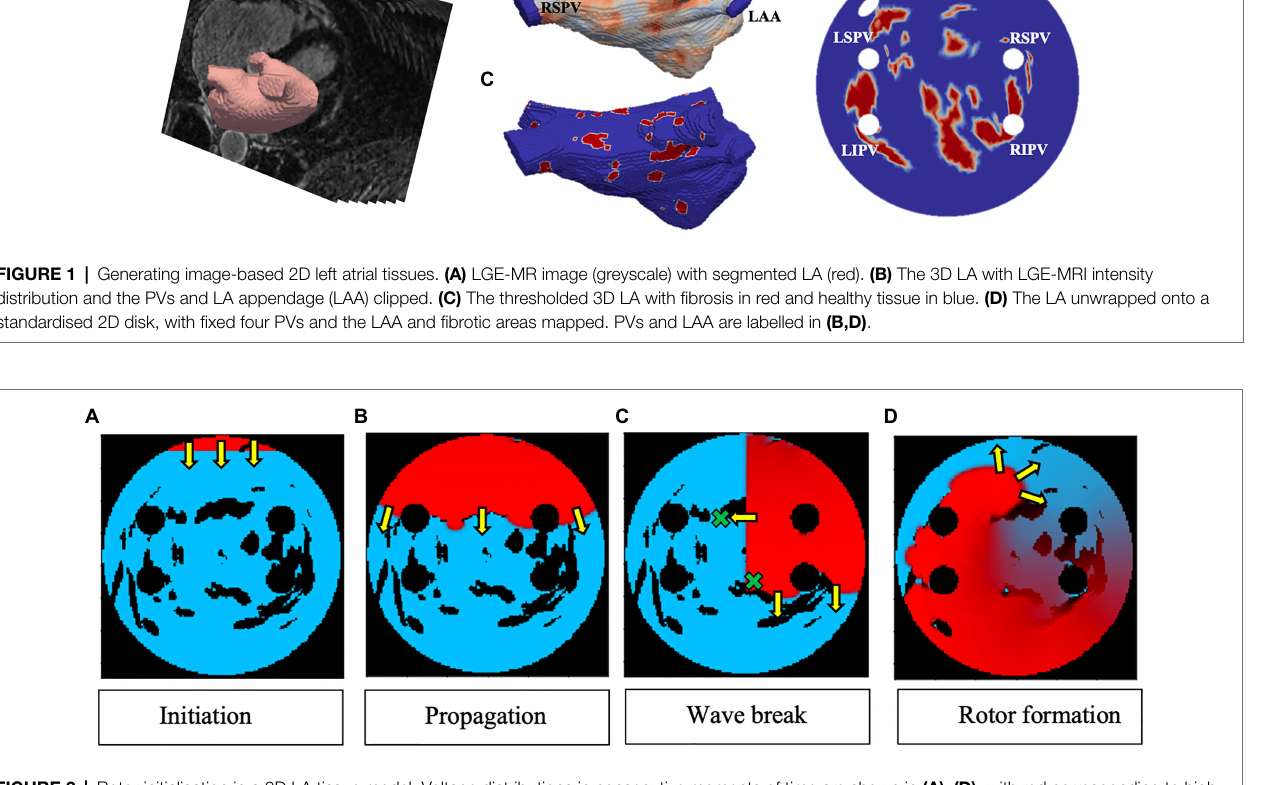
FIGURE 2 | Rotor initialisation in a 2D LA tissue model. Voltage distributions in consecutive moments of time are shown in (A)–(D) , with red corresponding to high voltage, blue to the resting potential, and black to the PVs and area of fibrosis; yellow arrows show the directions of wave propagation. Green crosses show the locations of rotor initiation in two AF scenarios: a rotor illustrated in this figure corresponds to the lower right location, as seen in (C)